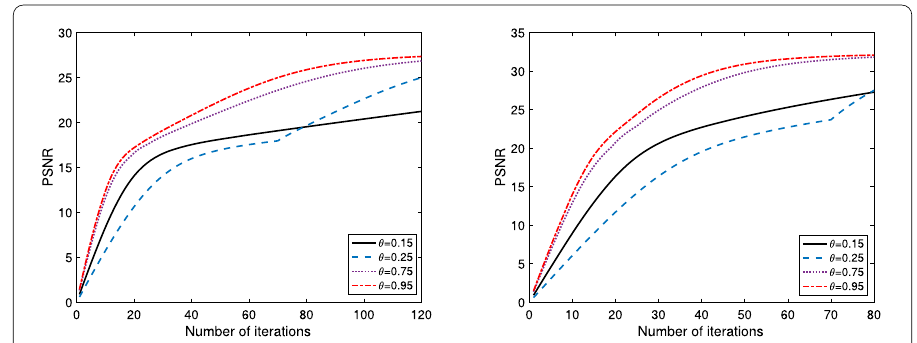
Figure 11 Graph of PSNR value and number of iterations